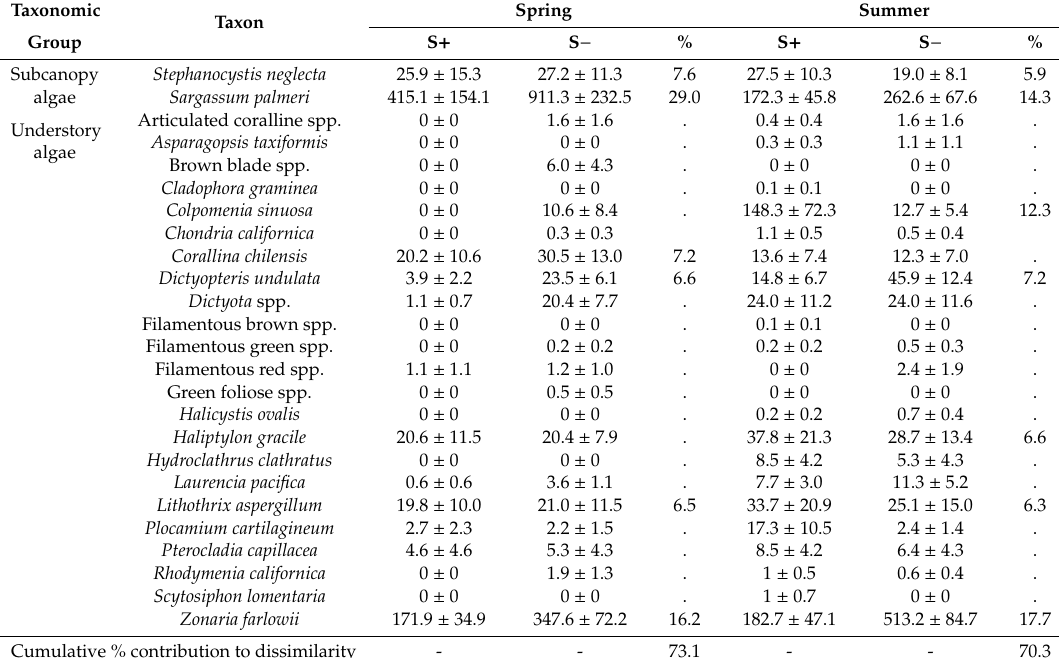
Green foliose spp.